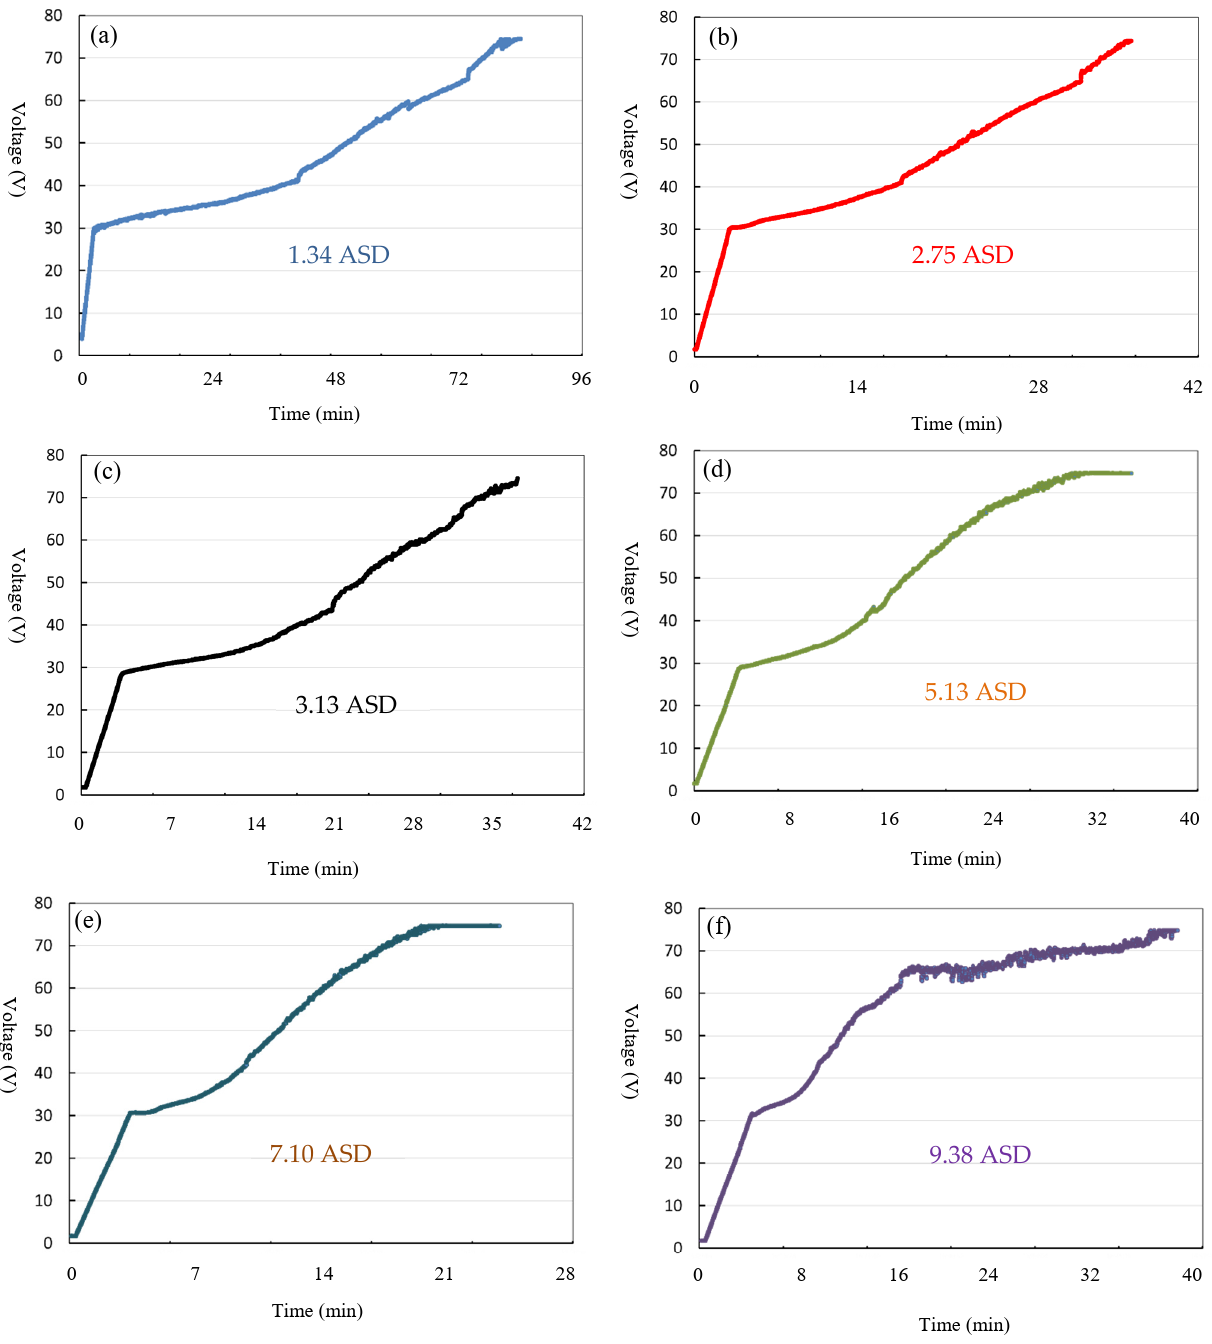
Figure 7. V-T curves of hard anodization with current densities of ( a ) 1.34, ( b ) 2.75, ( c ) 3.13, ( d ) 5.13, ( e ) 7.10, and ( f ) 9.38 ASD,